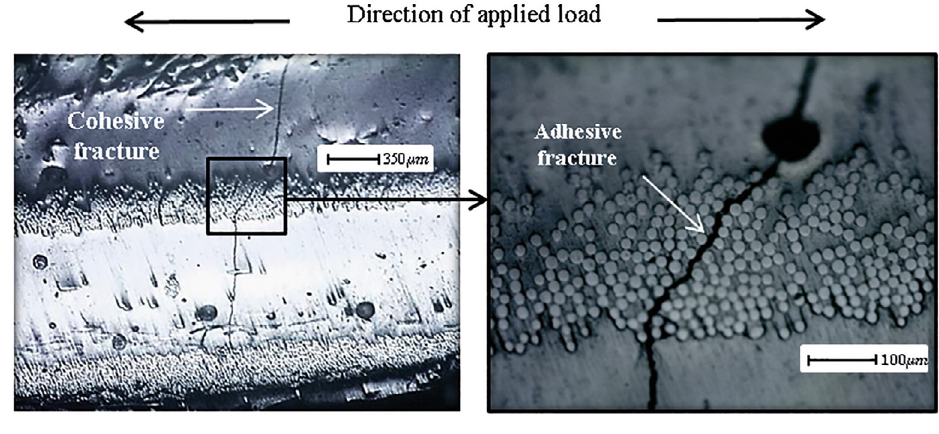
Figura 12. Fracture characteristics – HSCL laminate.